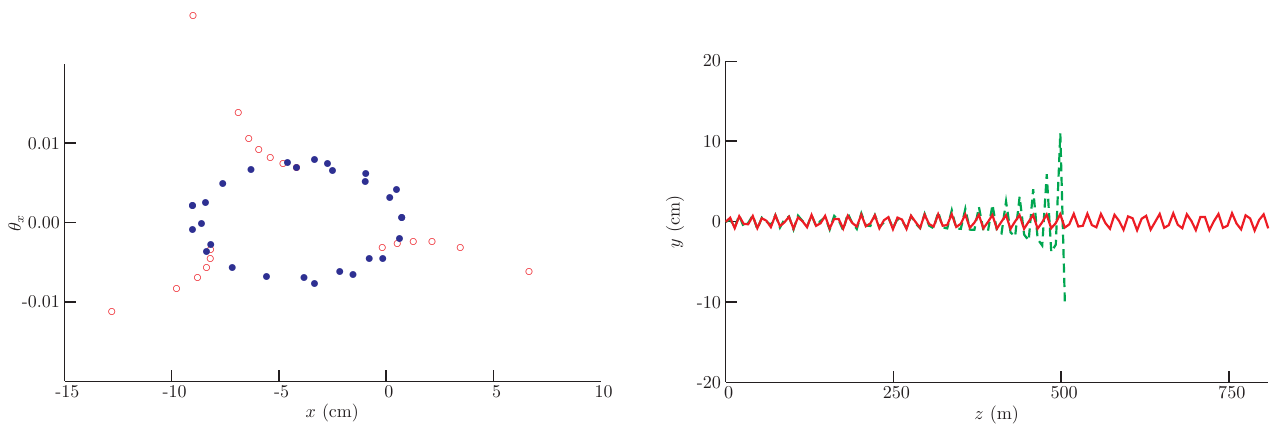
FIG. 33. (Color) Horizontal phase space from tracking at 5 : 1 GeV =c at the outer edge of the acceptance. Open circles are without the body sextupole fields and show a third-order resonance; filled circles are with the body sextupole